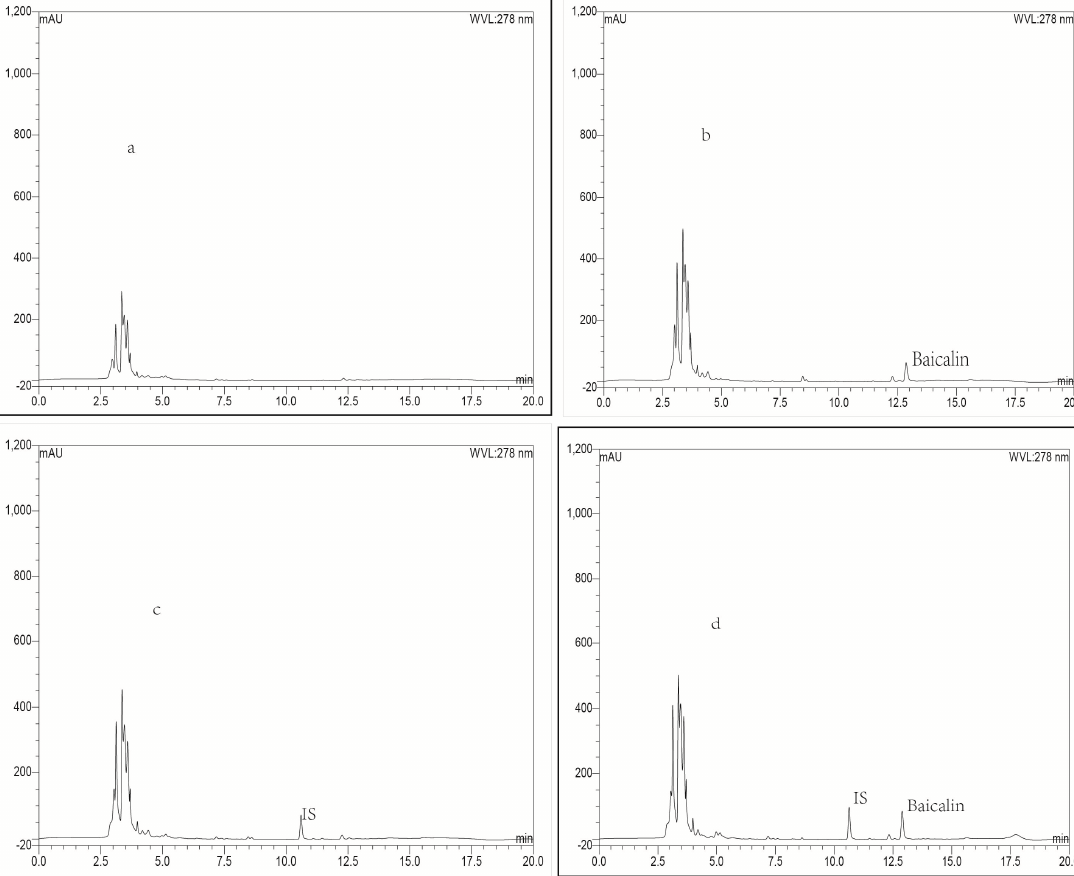
Figure 3. Representative LC-UV chromatograms obtained for blank lung tissue ( a ); blank lung tissue spiked with baicalin ( b ); blank lung tissue spiked with IS ( c ) and lung biosample collected from a rabbit at 0.25 h after intravenous administration of baicalin-loaded liposomes at a dose of 10 mg/kg + IS ( d ).